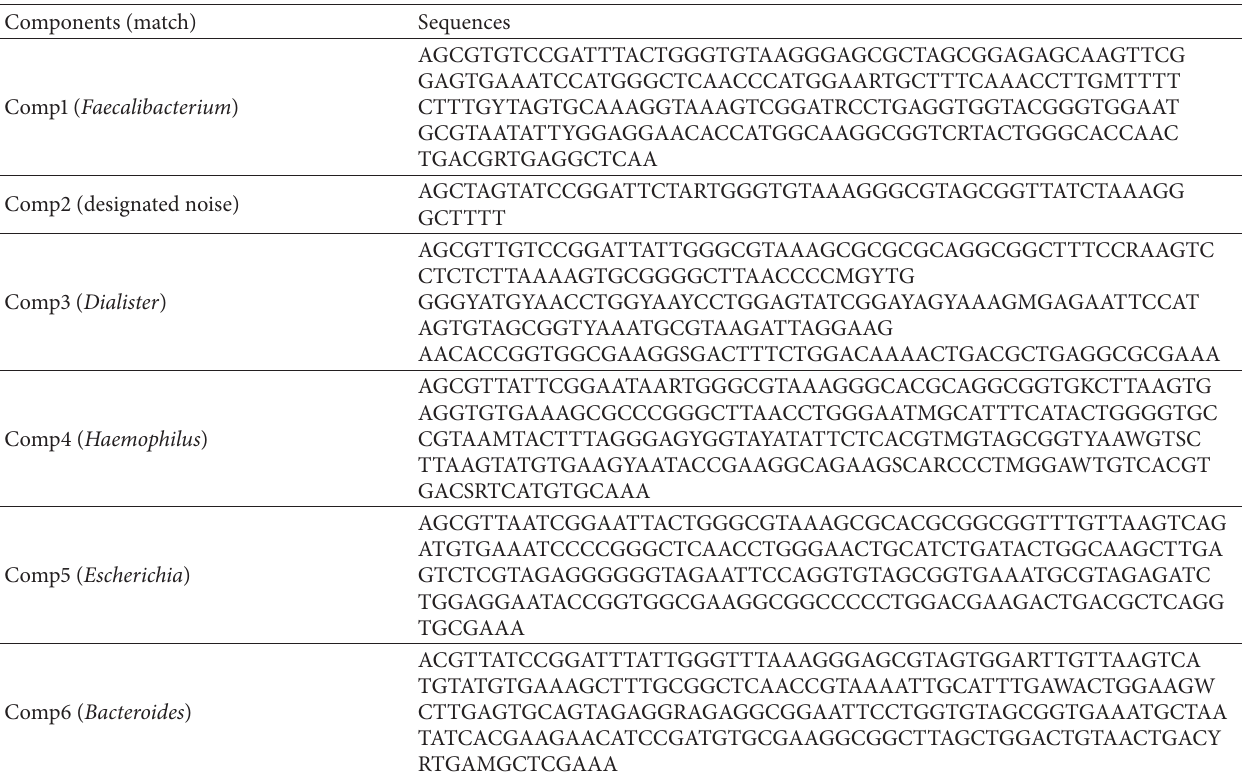
Table 1: Base-called MCR components.